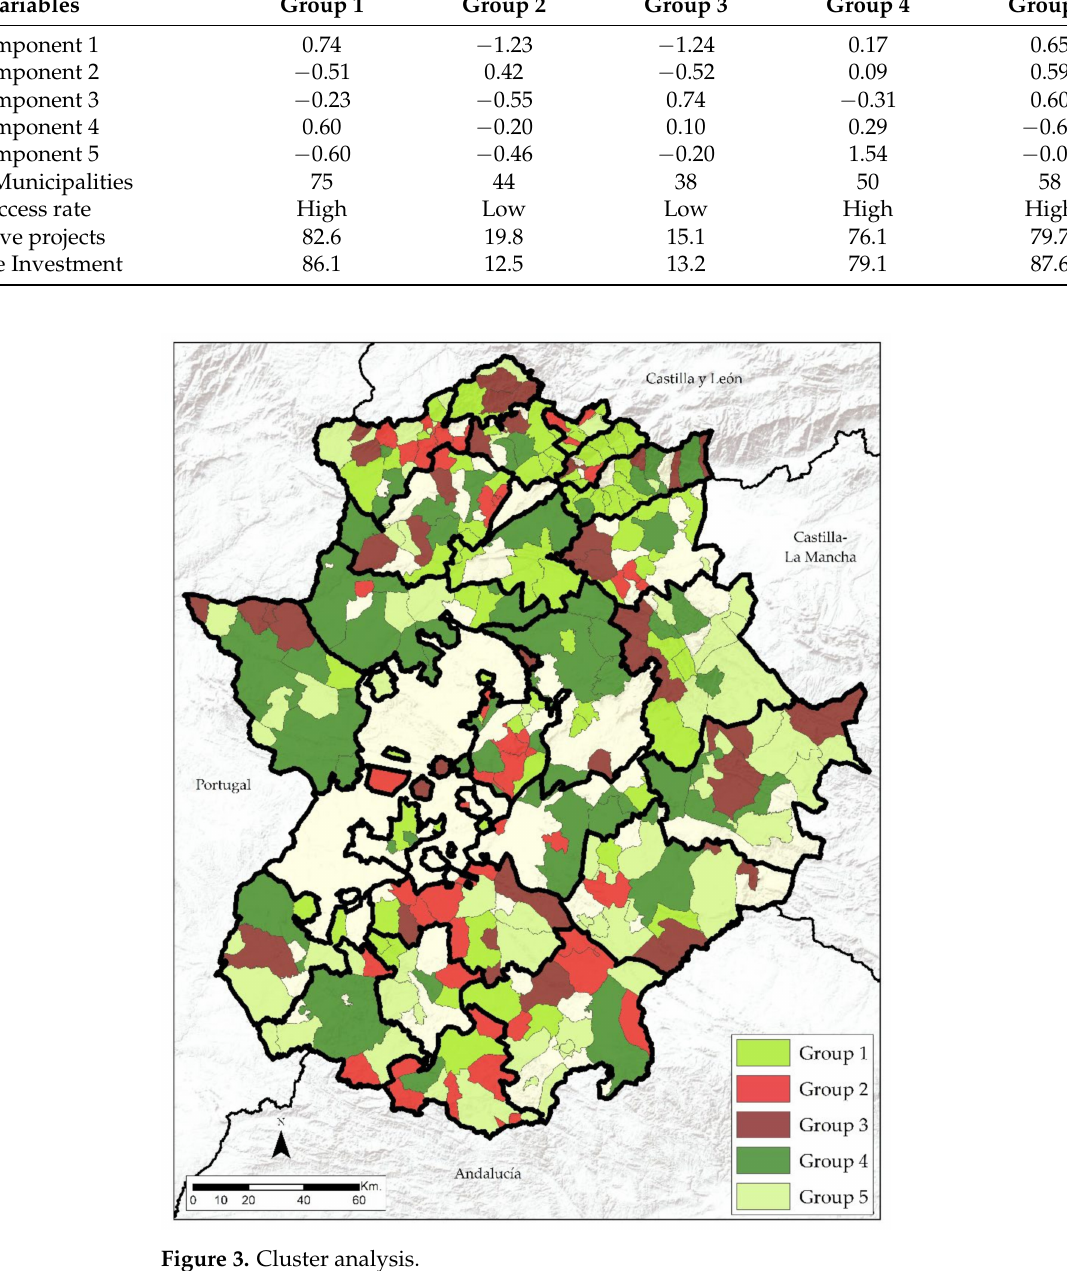
Figure 3. Cluster